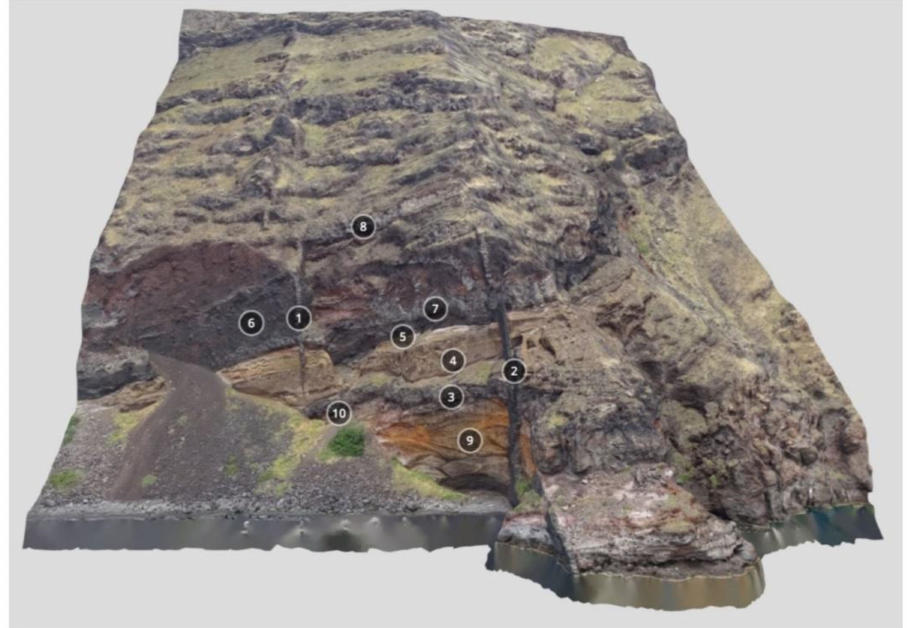
Figure 14. Panorama of the Cape Epta Paides 3D